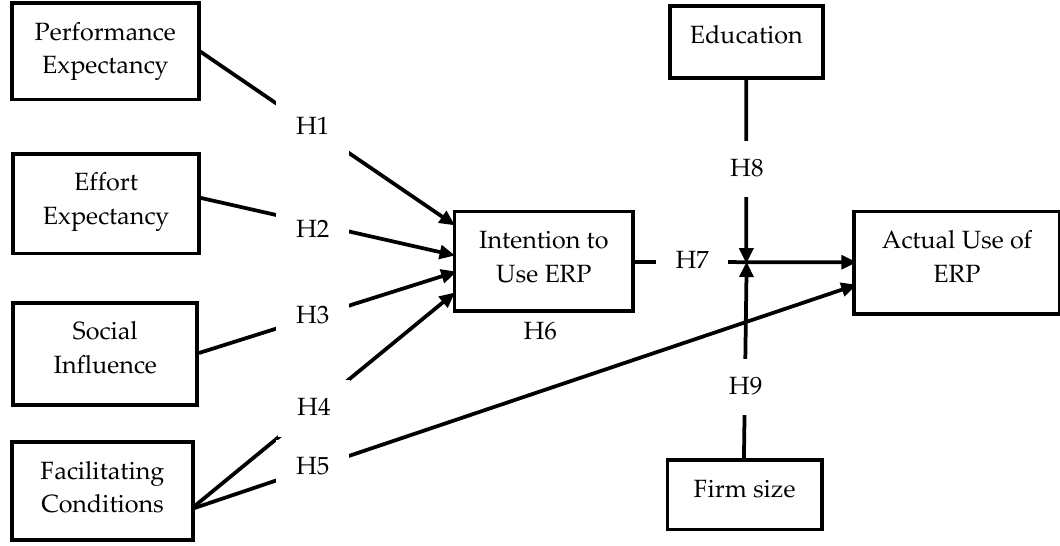
Figure 1. Conceptual framework of the study.